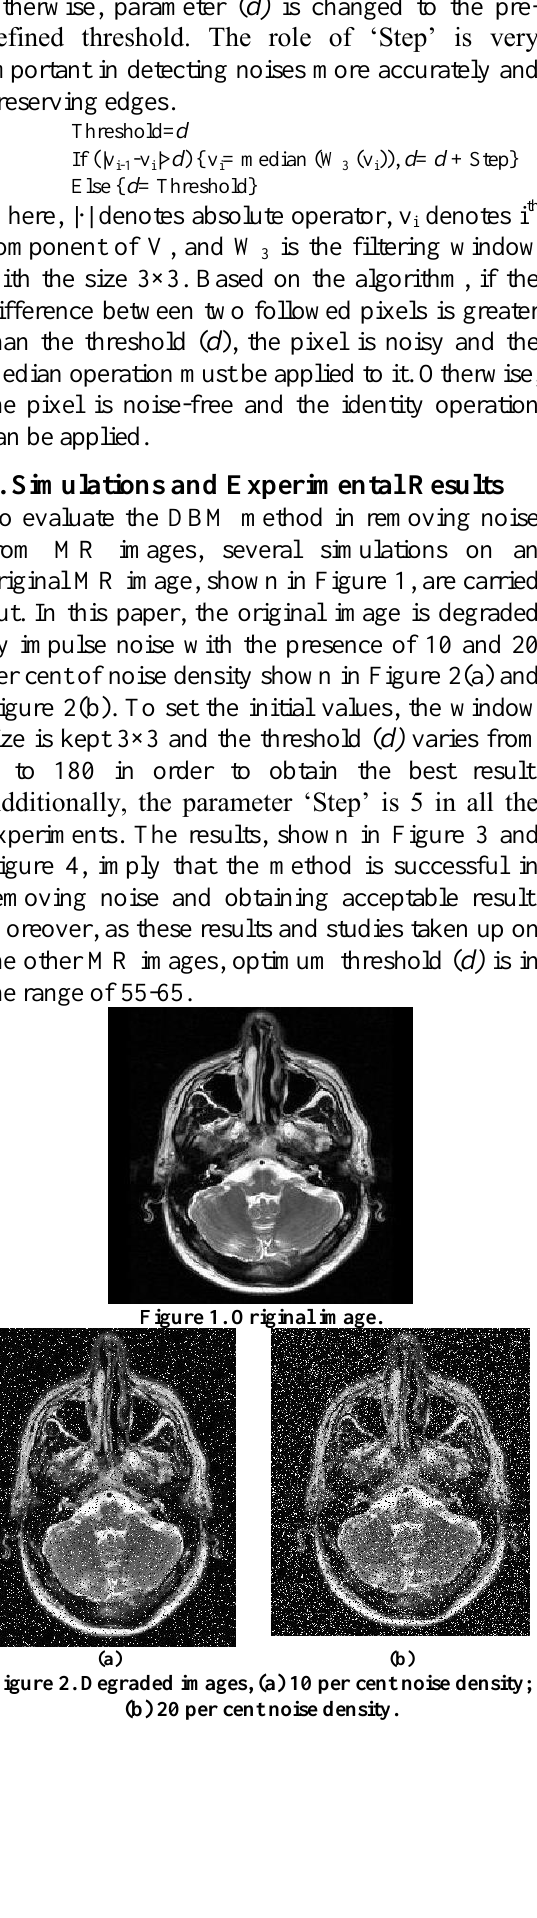
(a) (b) Figure 2. Degraded images, (a) 10 per cent noise density; (b) 20 per cent noise